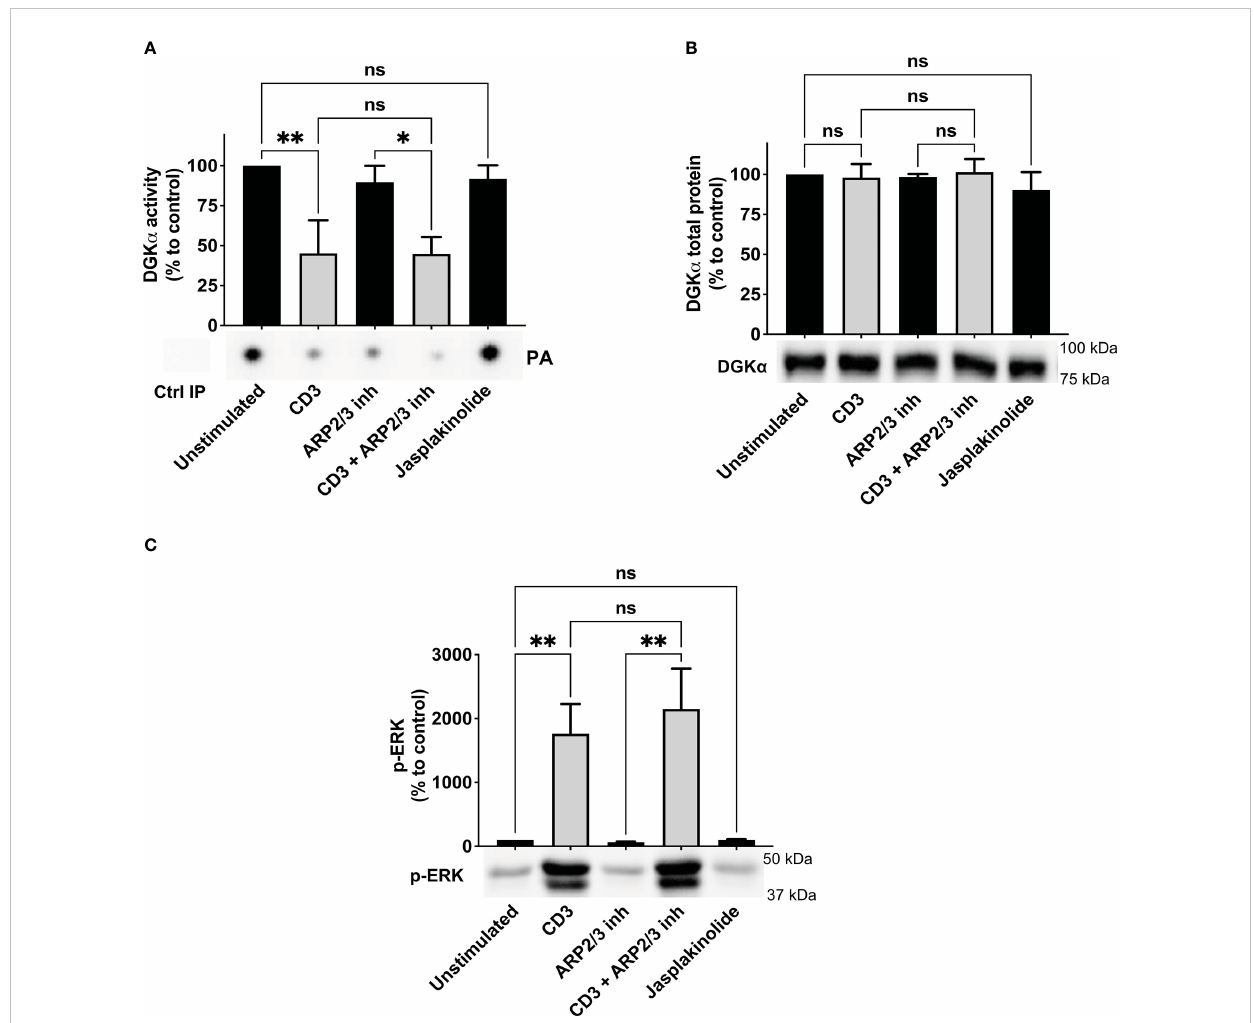
FIGURE 2 ARP2/3 has no effect on DGK a inhibition upon CD3 stimulation Jurkat cells were treated with ARP2/3 inhibitor (CK666 – 60 µM) or jasplakinolide (0.5 m g/ml) for 30 minutes and/or were stimulated with CD3 agonist (UCHT1 10 m g/ml for 15 minutes). Post-stimulation, cells were lysed and: (A) immunoprecipitated with anti-DGK a antibody followed by DGK activity assays; the lower panel is a representative assay and the upper panel is the mean ± SEM of at least three experiments normalized as the % of unstimulated cells. (B) Total cell lysates were analysed by western blotting with anti DGK a antibodies; the lower panel is a representative blot and the upper panel is the mean ± SEM of at least three experiments normalized as the % of unstimulated cells. (C) Total cell lysates were analysed by western blotting with anti-pERK antibodies; the lower panel is a representative blot and upper panel is the mean ± SEM of at least three experiments normalized as the % of unstimulated cells. ns, non signi fi cant. A single, double, triple, and four asterisks denote their signi fi cance of a p-value ≤ 0.05, ≤ 0.01, ≤ 0.001 and ≤ 0.0001 respectively in all